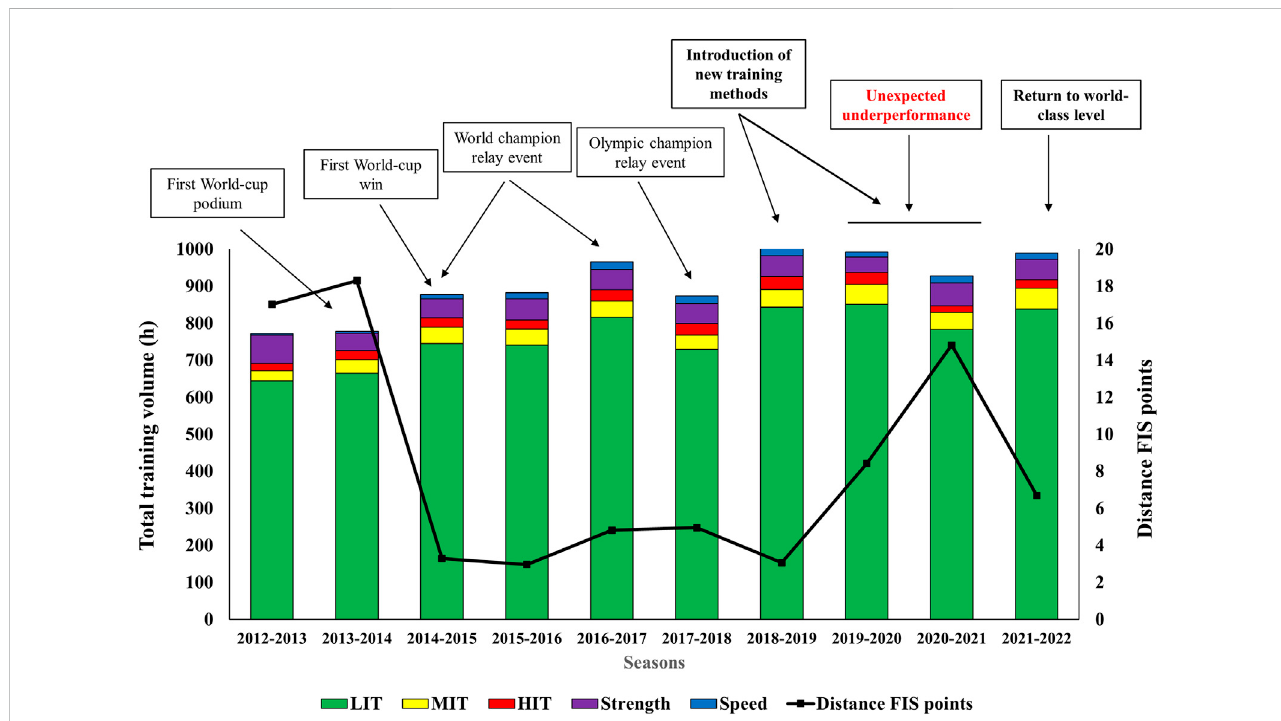
FIGURE 1 Longitudinal training data and corresponding performance changes (distance FIS points) across ten seasons including two seasons of unexpected underperformance and the season returning to world-class level in a male cross-country skier. LIT indicates low-intensity training; MIT, moderate-intensity training; HIT, high-intensity